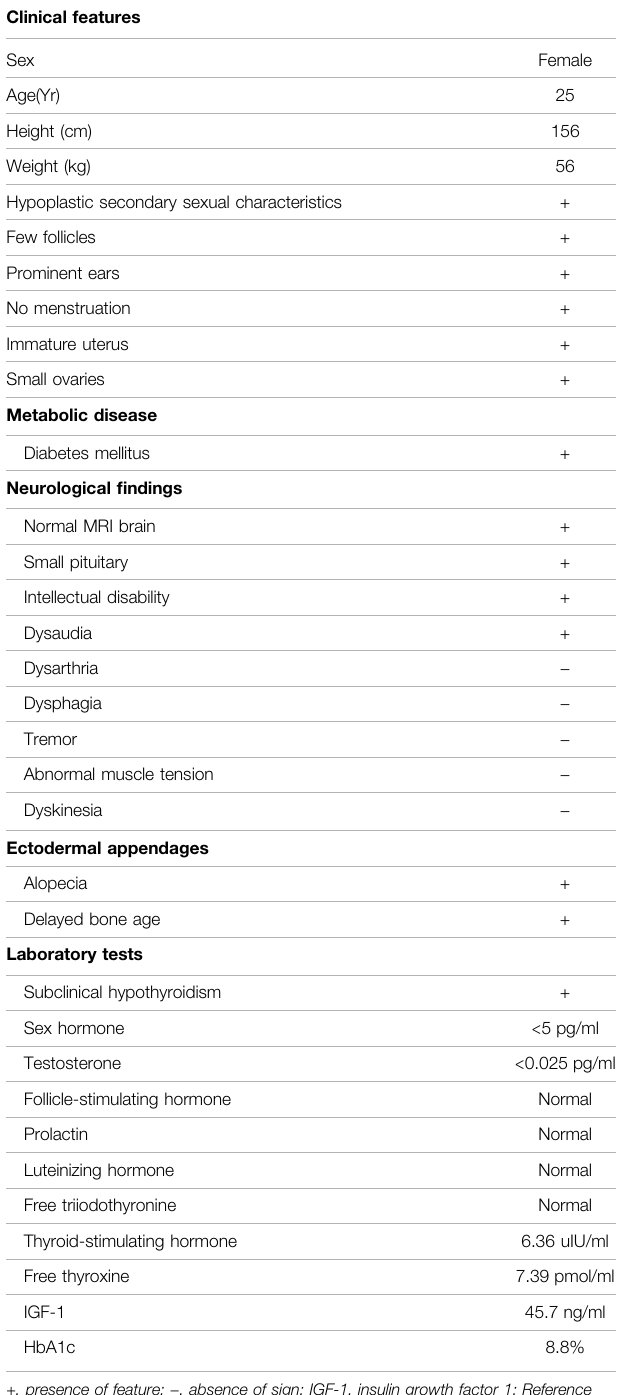
TABLE 1 | The patient ’ s main symptoms and laboratory tests. Clinical